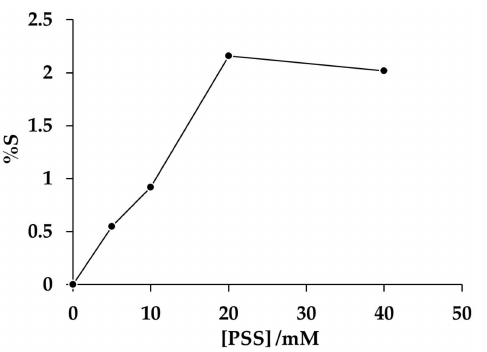
Figure 9. Percentage of content of sulfur in the PAni / PSS deposits (%S) as a function of polyelectrolyte concentration in solution used to modify the commercial AFN membranes.